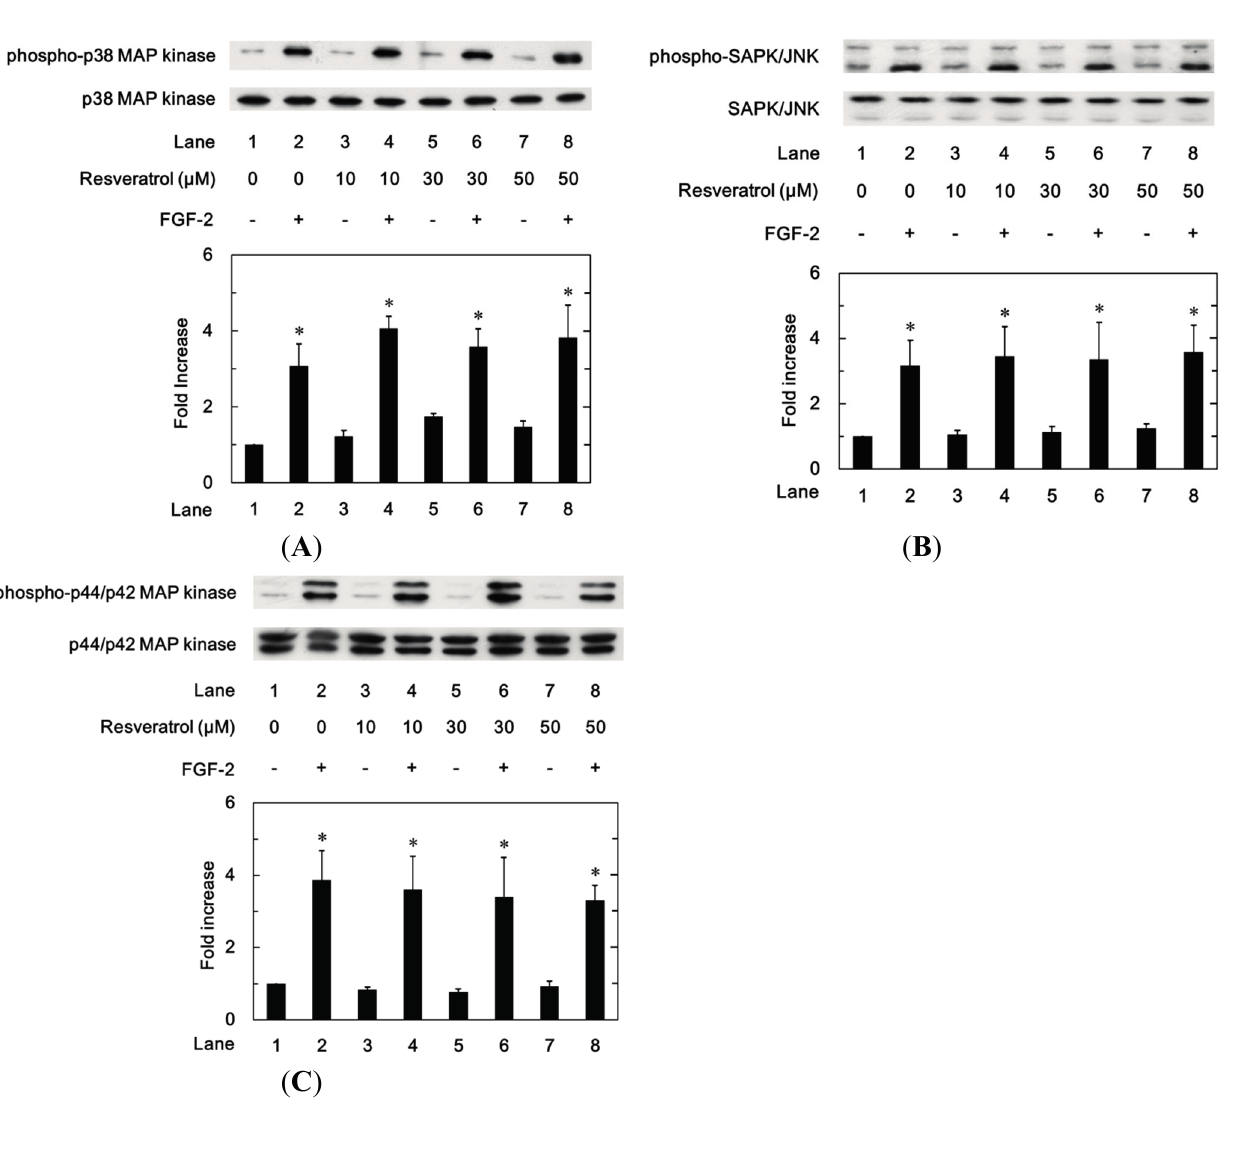
Figure 4. The effects of resveratrol on the FGF-2-induced phosphorylation of p38 MAP kinase ( A ), SAPK/JNK ( B ) or p44/p42 MAP kinase ( C ) in MC3T3-E1 cells. The